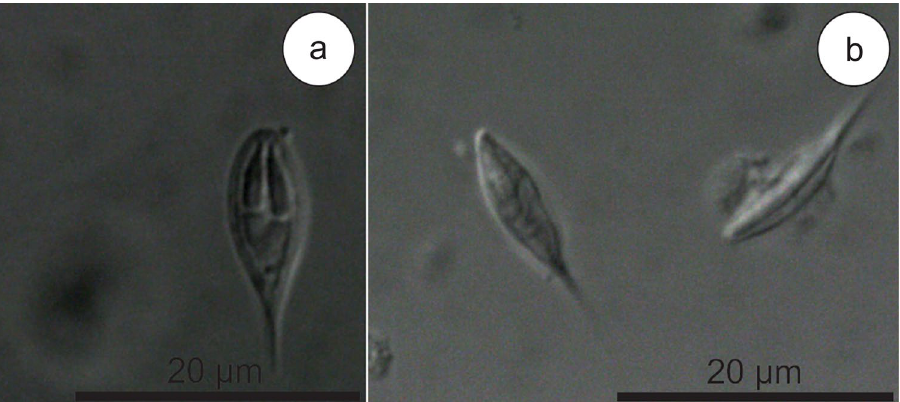
Figure 4. ( a ) Mature myxospore of Henneguya breviscauda n. sp. found parasitizing the gills in front view. Note the polar capsules in unequal size. ( b ) Henneguya breviscauda n. sp. myxospores in side